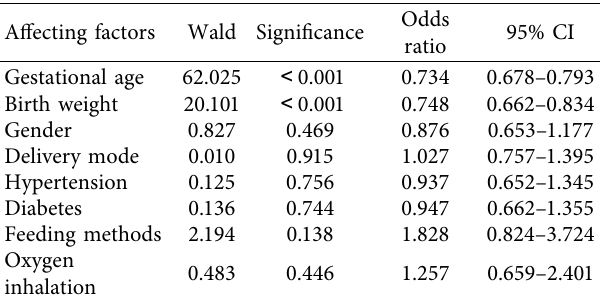
Table 5: Factors affecting ROP in premature infants by logistic regression